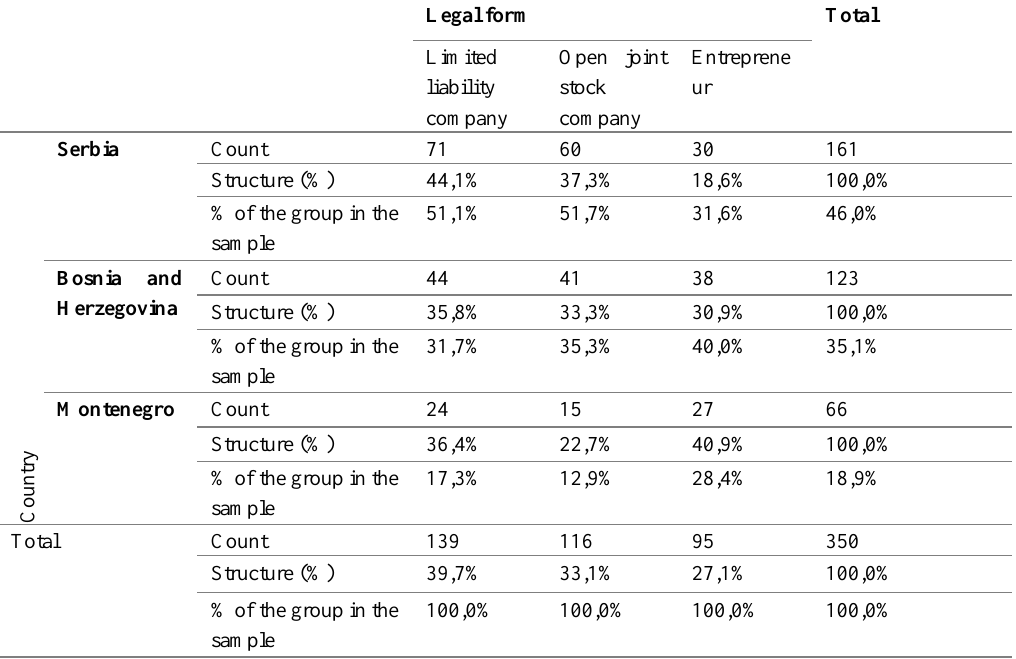
Table 3: The Legal Form of Companies